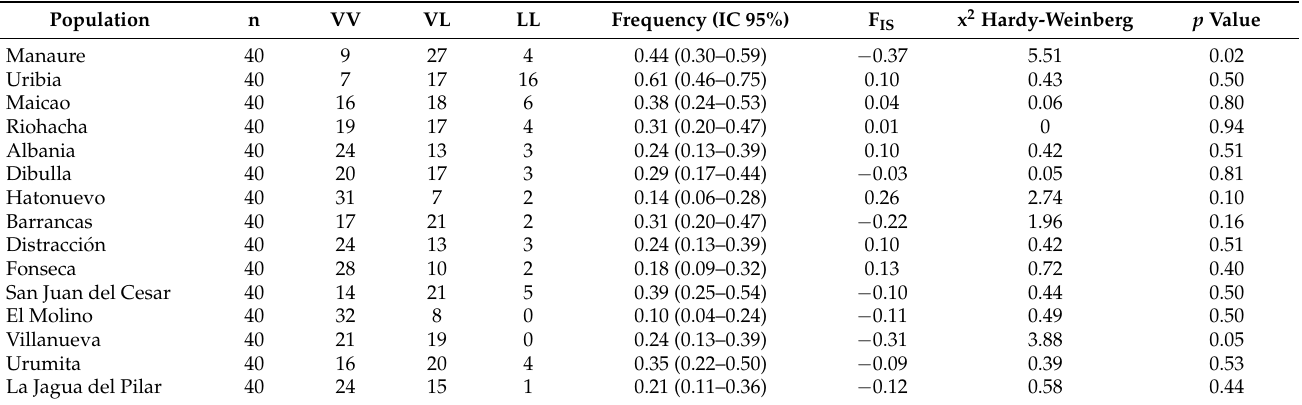
Figure 5. Distribution of pyrethroid resistance (% of mortality to the DD) to ( a ) permethrin, ( b ) deltamethrin, and ( c ) lambda–cyhalothrin in Ae. aegypti populations from La Guajira, Colombia using IDW interpolation. Table 1. Allele and genotype frequencies of V410L in populations of Ae. aegypti from the department of La Guajira,